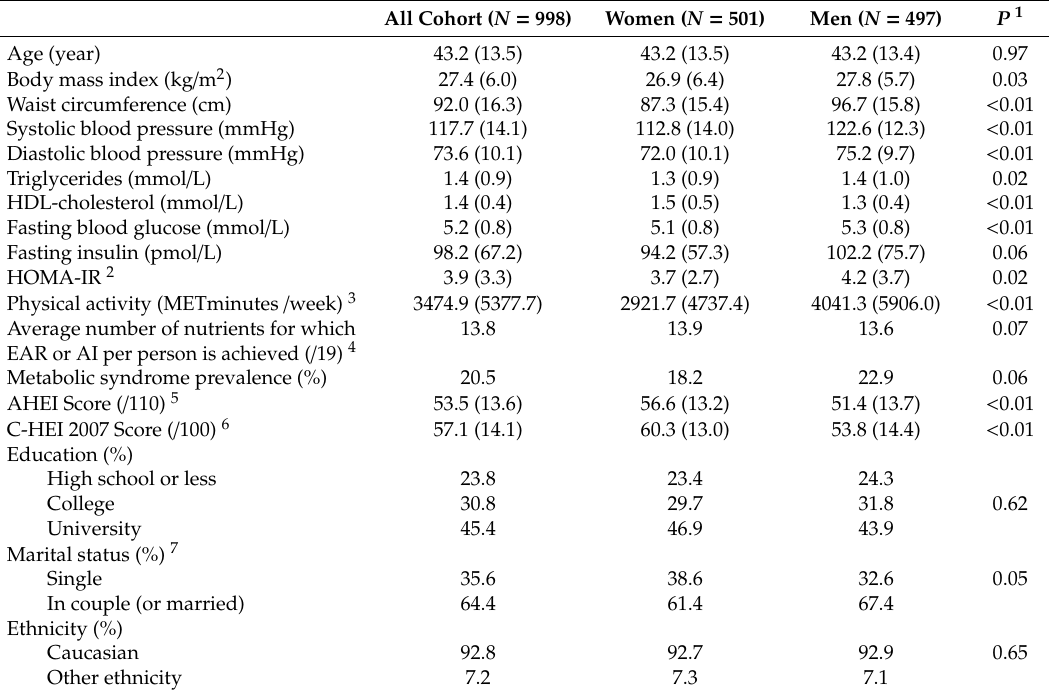
Table 1. Participants’ characteristics ( N =